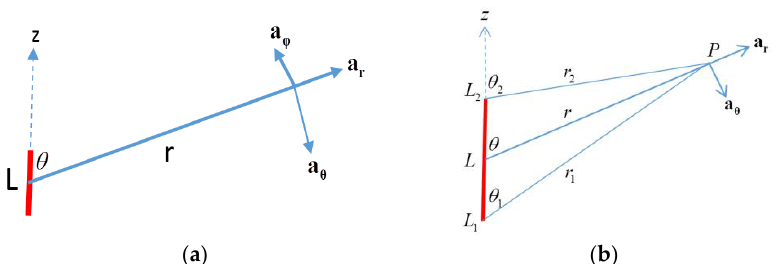
Figure 1. Geometry relevant to the derivation of equations presented in this paper. ( a ) Hertzian dipole; ( b ) long dipole. Observe that in defining the unit vectors a r , a θ , and a ϕ we are using a spherical coordinate system with the centre of the dipole located at the origin of coordinate system. In this coordinate system r is the radial distance, θ is the polar angle, and ϕ is the azimuthal angle. a r , a θ , and a ϕ are unit vectors in the direction of increasing radial distance, polar angle and azimuthal angle, respectively.